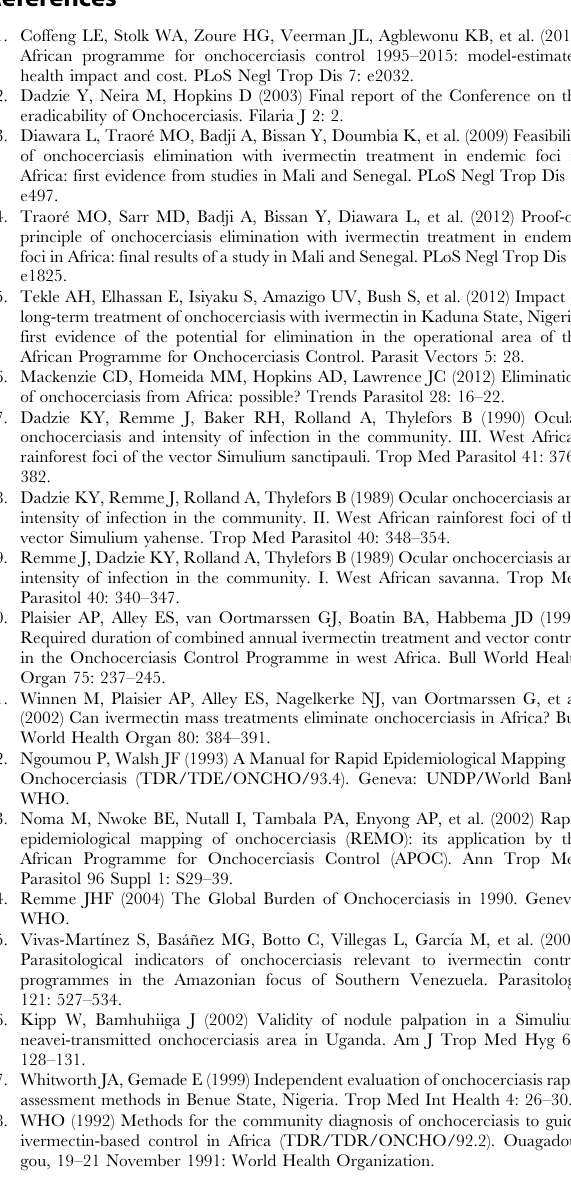
Table S1 Weights used to standardize mf prevalences. Table S2 Parameter estimates of the model, based on Bayesian hierarchical multivariate logistic regression. Text S1 Detailed description of the statistical model, and the methods used to estimate the model parameters with an explanation of how the model should be applied to data